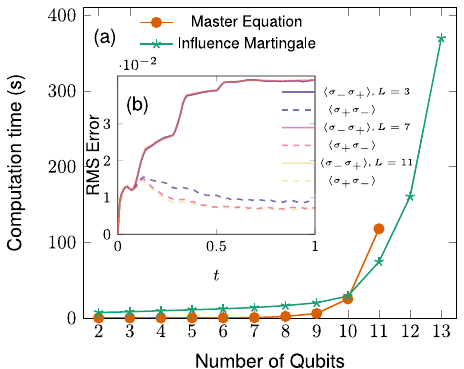
Fig. 6 Numerical performance of the in fl uence martingale. a Computation time for both the Master Equation and In fl uence Martingale method as a function of the amount of qubits in the chain. For the stochastic method, we generated 1000 realizations. For N > 11 the use of the master equation becomes unwieldy on our laptops whereas we were able to take further points using the unraveling. b The root mean square error of the populations averaged over all